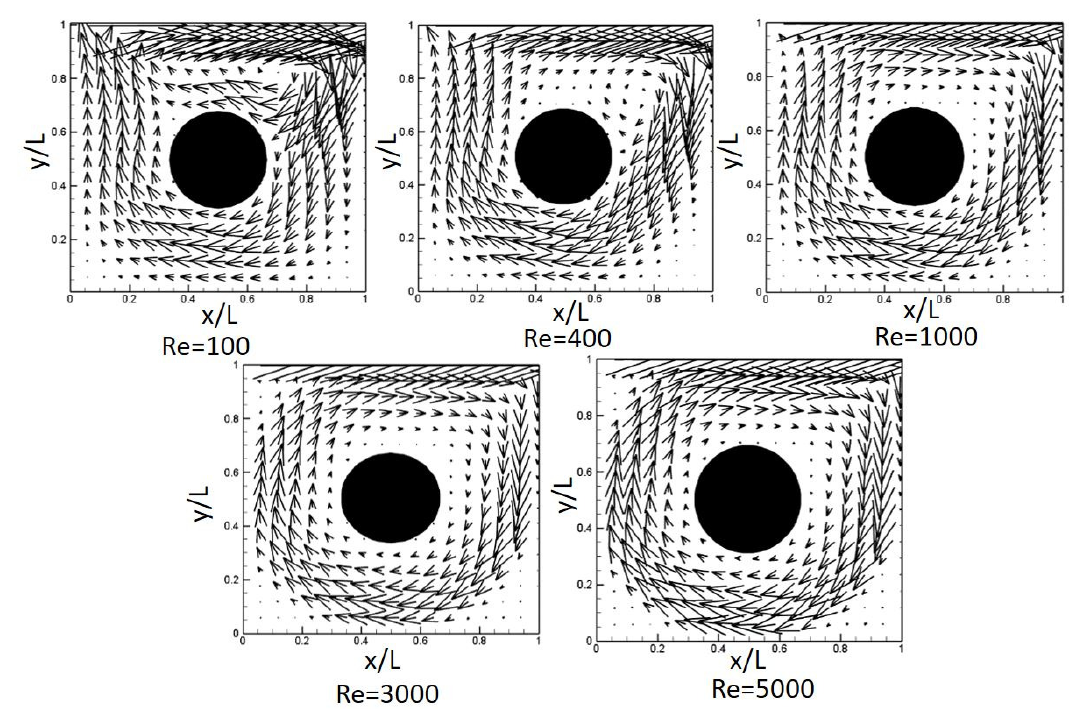
Figure 9. Vector fields for the changing Re